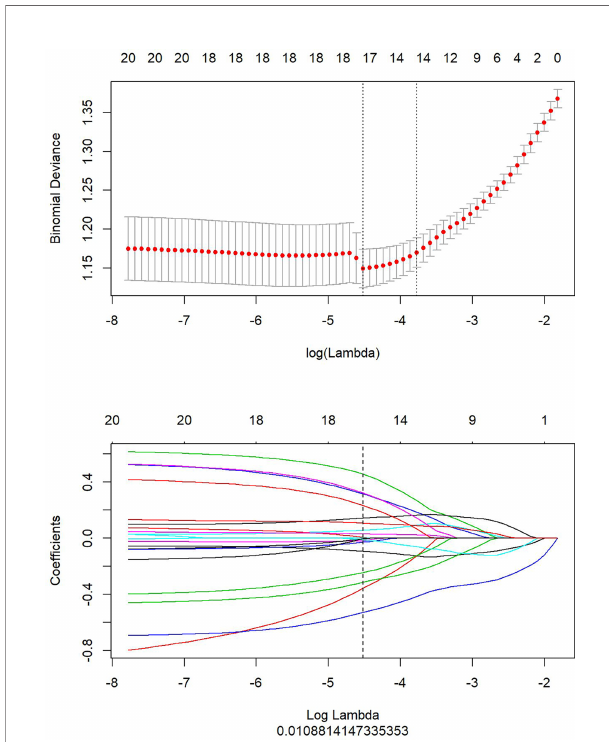
FIGURE 4 | Optimal feature subsets selected from the enhanced T1- weighted imaging (T1WI) sequence using Least Absolute Shrinkage and Selection Operator (LASSO) analysis to construct the fi nal model. The upper part shows the optimal penalty coef fi cient ( l ) selected at the lowest point of the curve by LASSO. The lower part displays the penalty graph of the variation coef fi cients of the 680 imaging features, with the vertical dotted line indicating that a total of 19 of the most signi fi cant features are obtained at the optimal l value when LogLambda equals